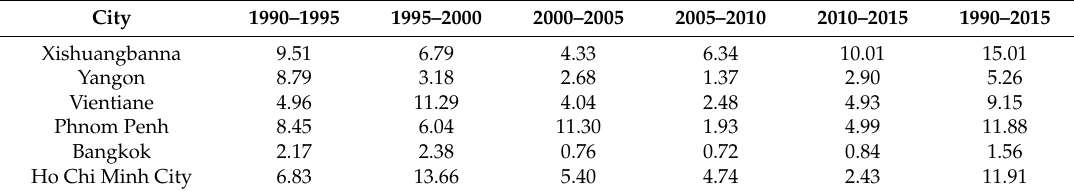
Table 9. Urban expansion intensity (UEI) of typical cities in the GMS.